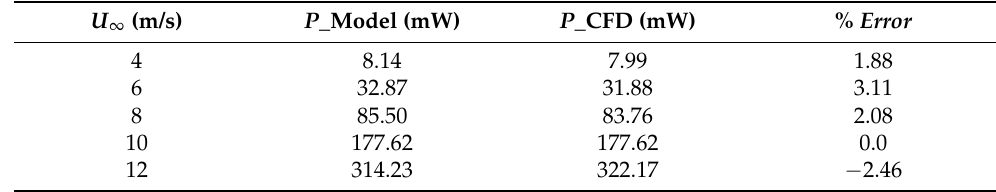
Table 1. Predicted power output of an isolated single rotor by the present method and the comparison with the CFD results (reproduced with permission from Hara et al.